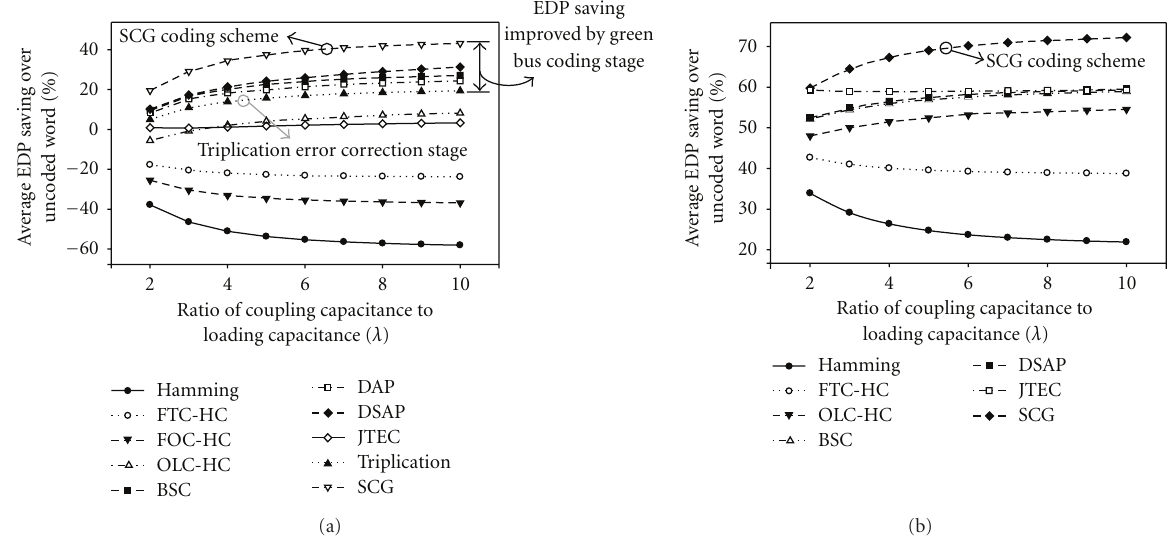
Figure 15: The energy-delay product (EDP) reduction to uncoded code under di ff erent values of λ with (a) full swing signal and (b) the lowest swing signal.